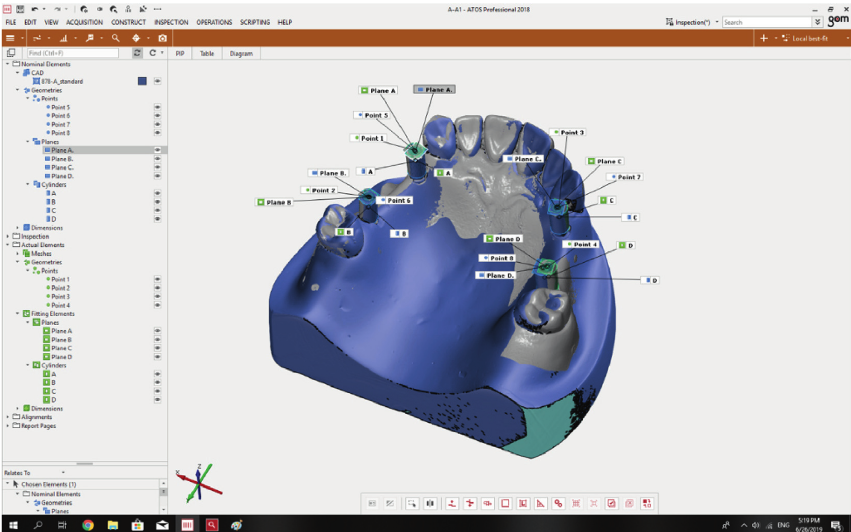
Figure 4: Assessment and comparison of the scanned models with the reference